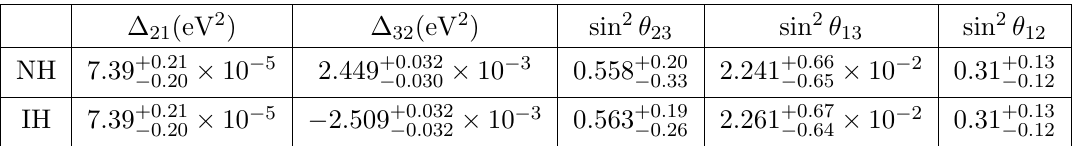
Table 2. Bounds on neutrino mass and mixing parameters from neutrino oscillation experiments, for both normal hierarchy (NH) and inverted hierarchy (IH) of the neutrino mass spectrum. The error bars shown correspond to 1 (cid:27)